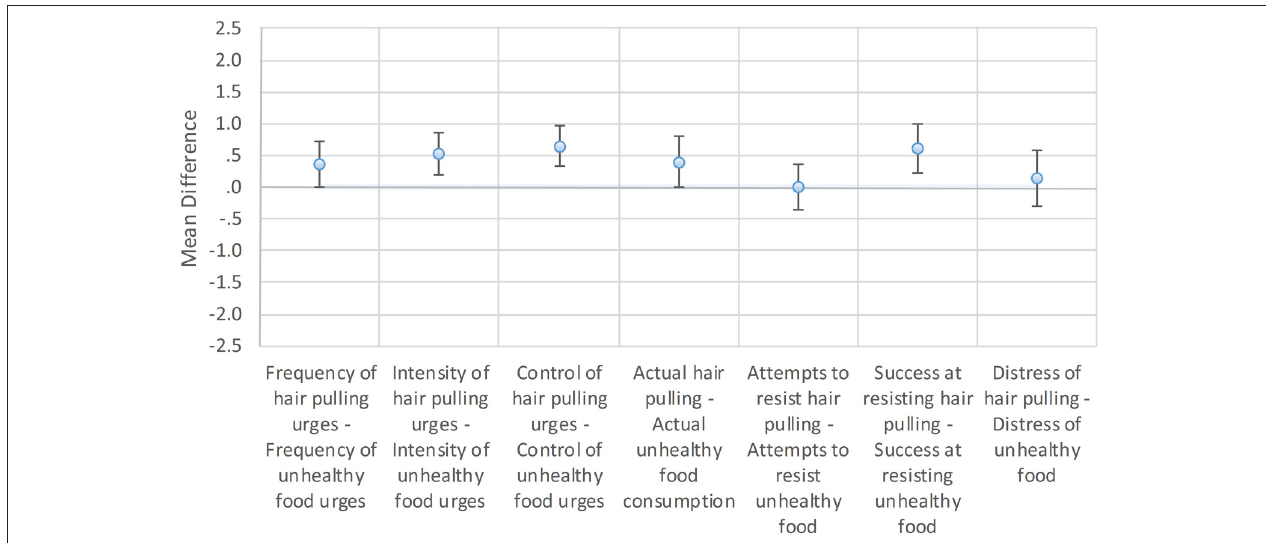
FIGURE 1 | Mean differences between hair-pulling urge properties and unhealthy food urge properties. UF + group: Mean differences between likert (0–4) scale responses on the Massachusetts General Hospital Hairpulling Scale (MGH-HPS) and the analogous Unhealthy Food Scale (UFS). Error bars show 99.3% confidence intervals to reflect the adjusted alpha level, which was set to 0.007 to correct for familywise error rate.